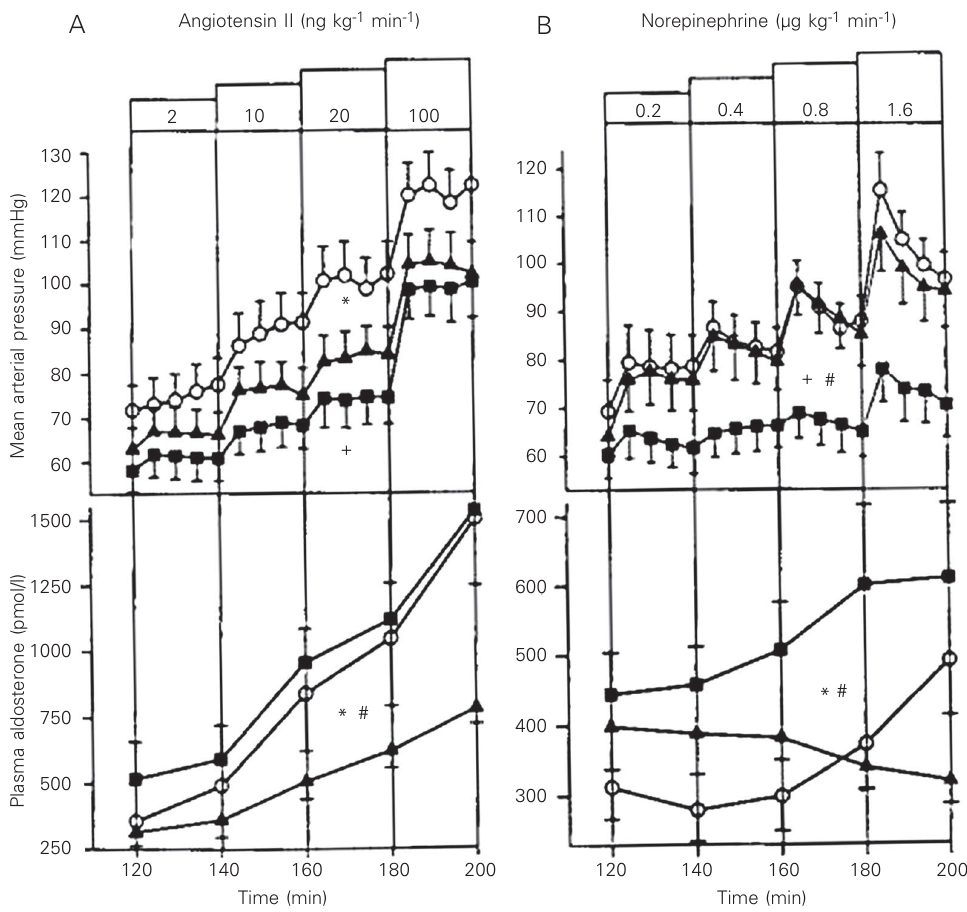
(min)Angiotensin II (ng kg -1 min -1 ) Norepinephrine (µg kg -1 min -1 ) BA Figure 1. Arterial pressure